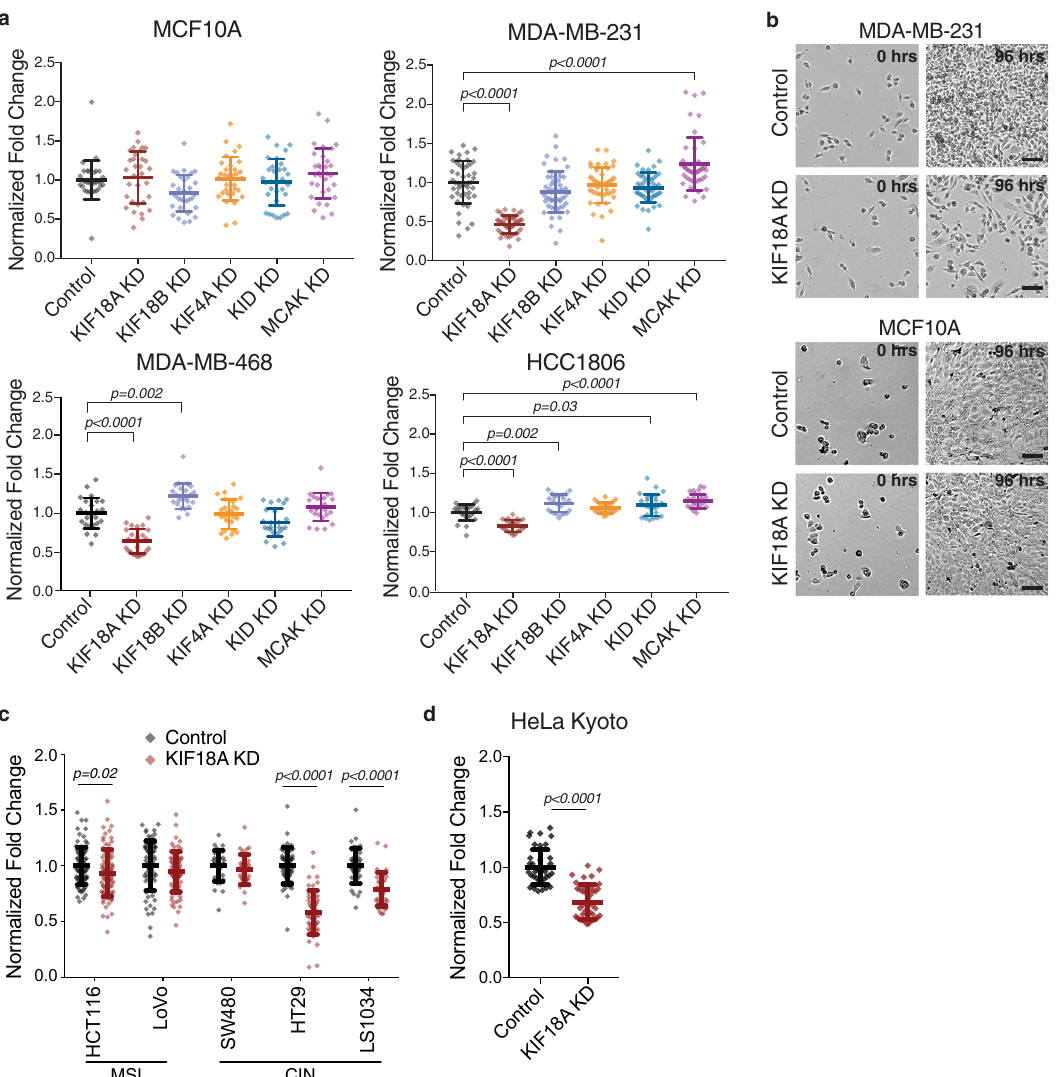
Fig. 1 KIF18A is required for the proliferation of chromosomally unstable cells. a Fold change in cell density (cells/mm 2 ) after 96 h in the indicated cell lines following knockdown (KD) of kinesin proteins. Data are normalized to cells treated with control siRNA. Raw cell counts for proliferation assays are available in Source Data. n (wells of cells/independent experiments) = 24/3 (MCF10A, MDA-MB-468, and HCC1806), 64/5 (MDA-MB-231 control and KIF18A KD), 36/3 (MDA-MB-231 KIF18B, KIF4A, KIF22, and MCAK KD). b Representative images of MDA-MB-231 (from fi ve experiments) and MCF10A cells (from three experiments) treated with either control or KIF18A siRNA. Scale bars are 100 microns. c Normalized fold change in cell density (cells/ mm 2 ) of MSI and CIN colorectal cancer cell lines after 96 h or until cells in the control populations reached con fl uence. n (wells of cells/independent